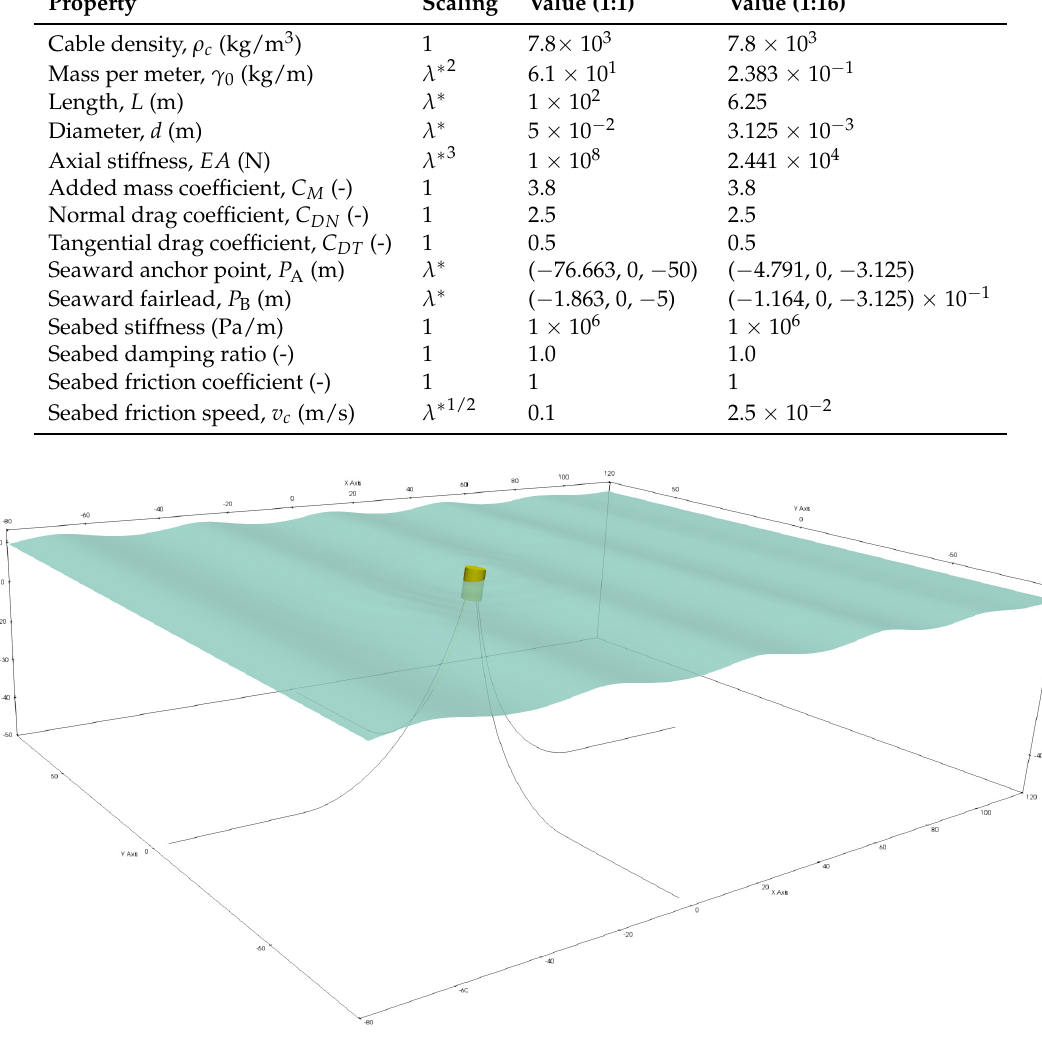
Figure 1. Layout of the numerical wave tank. The WEC is in the origin and the four mooring cables are symmetrically placed along the x – y coordinate